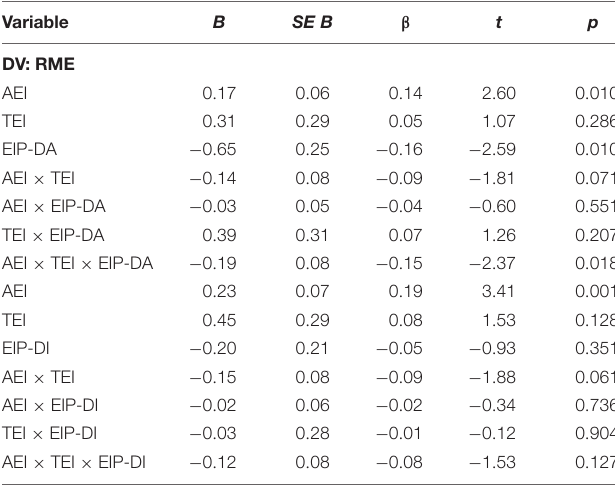
TABLE 2 | Summary of multiple regression analysis for variables predicting reading the mind in the eyes ( N =